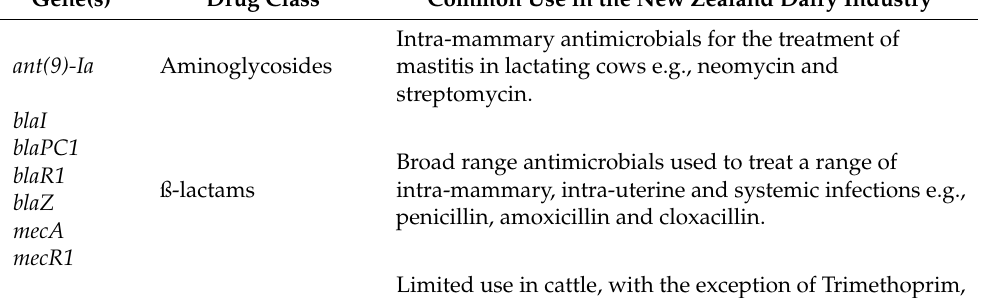
Table 2. The 14 resistance genes identified in the 57 S. aureus isolates with the drug classes influenced by these genes and the drugs common uses in the New Zealand dairy industry. Resistance genes have been grouped by their gene